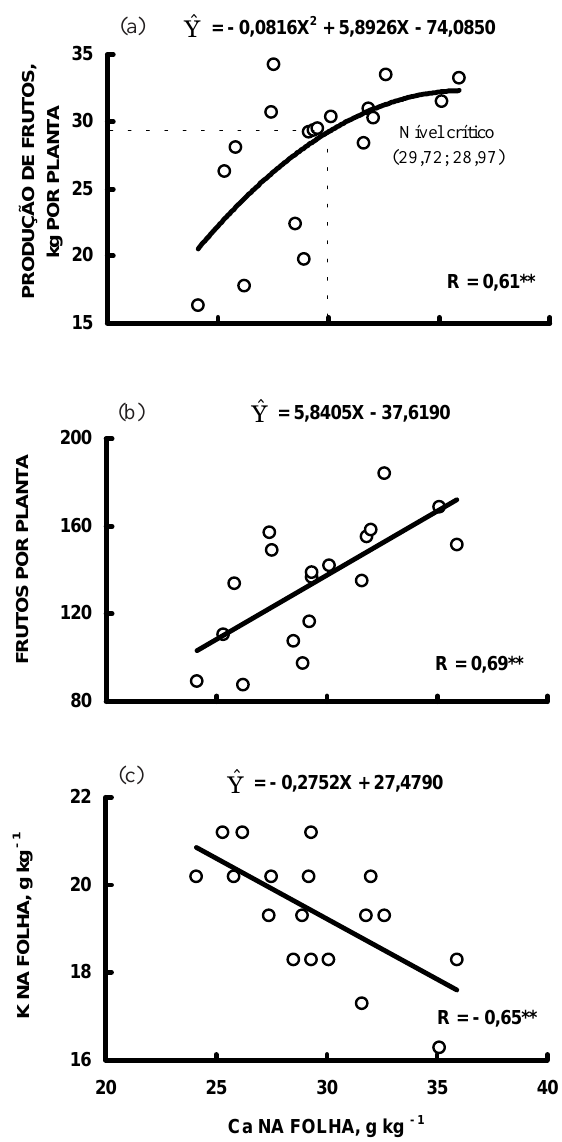
Figura 1. Relações entre produção de frutos (a), número de frutos (b) teores foliares de K (c) e teores foliares de Ca de seis sistemas de manejo do solo das entrelinhas de pomar de laranja pêra no Noroeste do